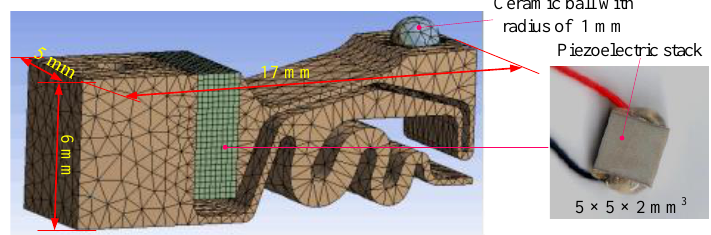
Figure 4. Finite element model of the actuator.